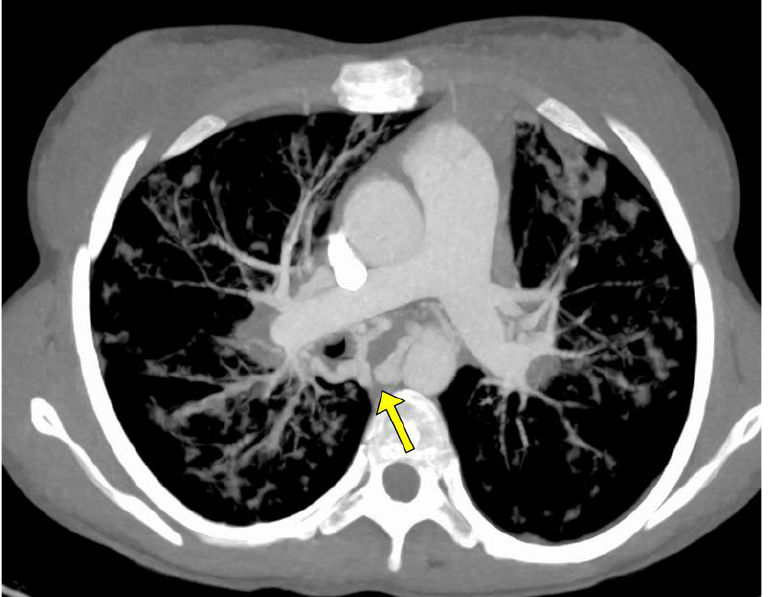
Figure 1. MIP axial Angio-CT showing ectatic and tourtuos (arrow) bronchial arteries in a young woman with sub-massive hemoptysis in CF.